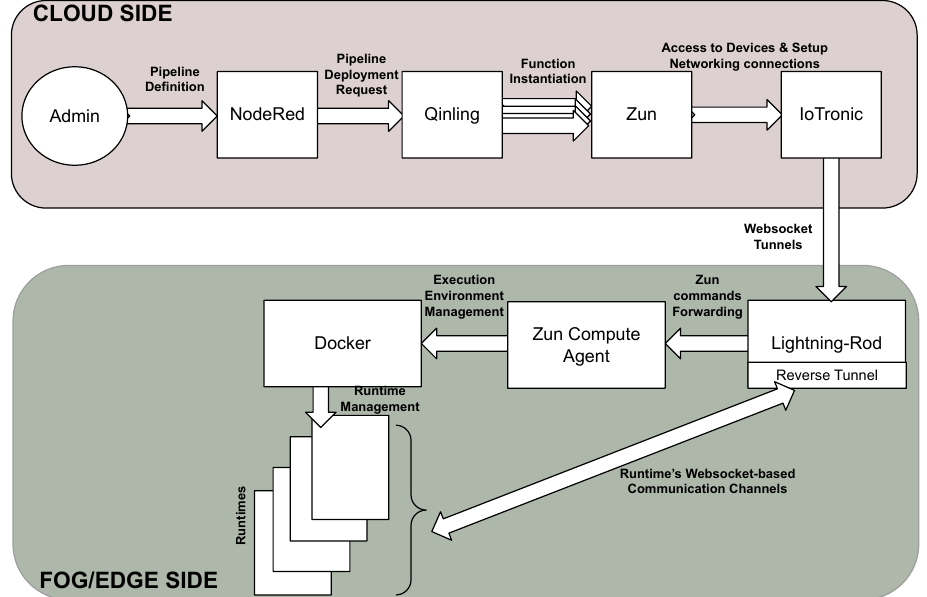
Figure 13. Typical pipeline definition workflow originated by an administrator.